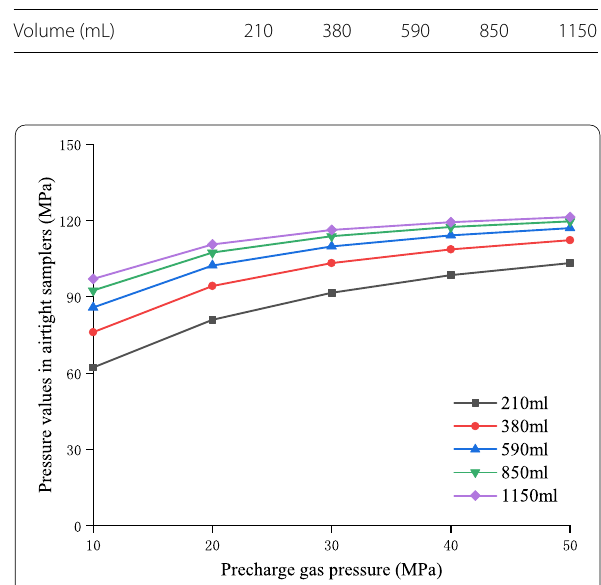
Figure 5 Relationship curve between precharge pressure of pressure compensator and pressure in